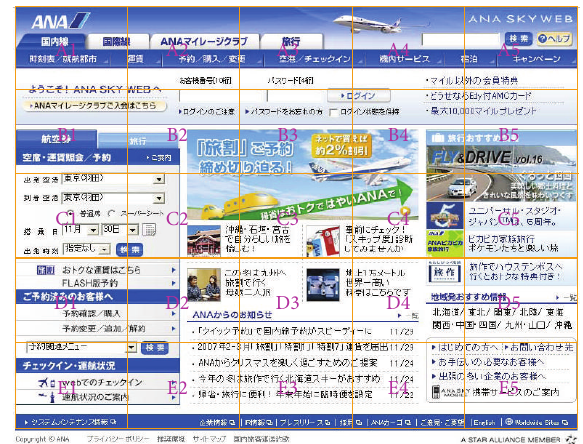
Figure 2: Segment